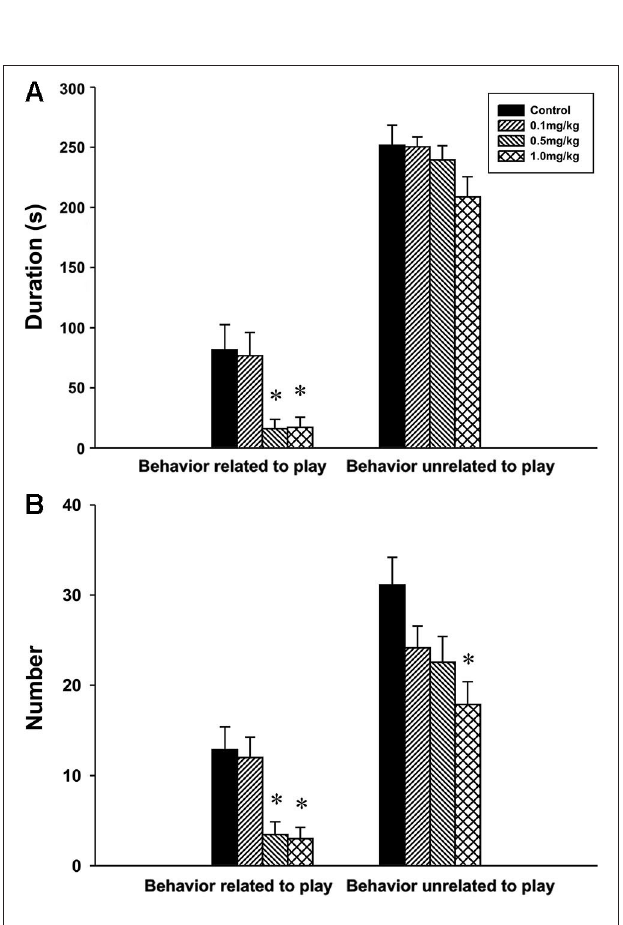
FIGURE 4 | Duration (A) and number (B) of social behavior related and unrelated to play in P32 animals exposed to CZP from P7 to P11 postnatal day . * Significant difference compared to control